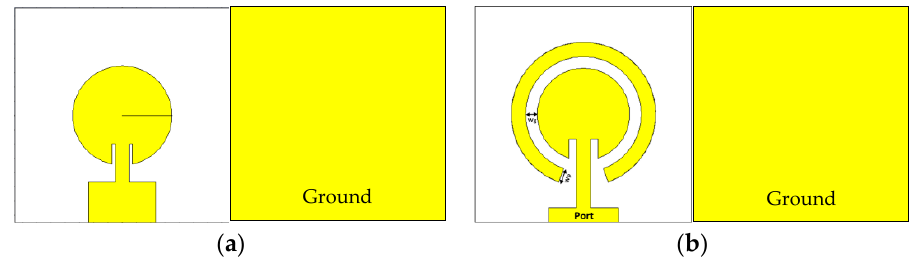
Figure 1. Single-element antenna ( a ) without and ( b ) with parasitic elements.